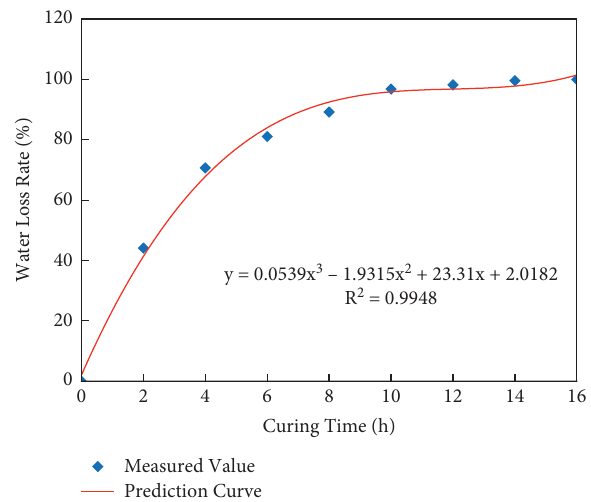
Figure 10: Relationship between water loss rate and curing time.